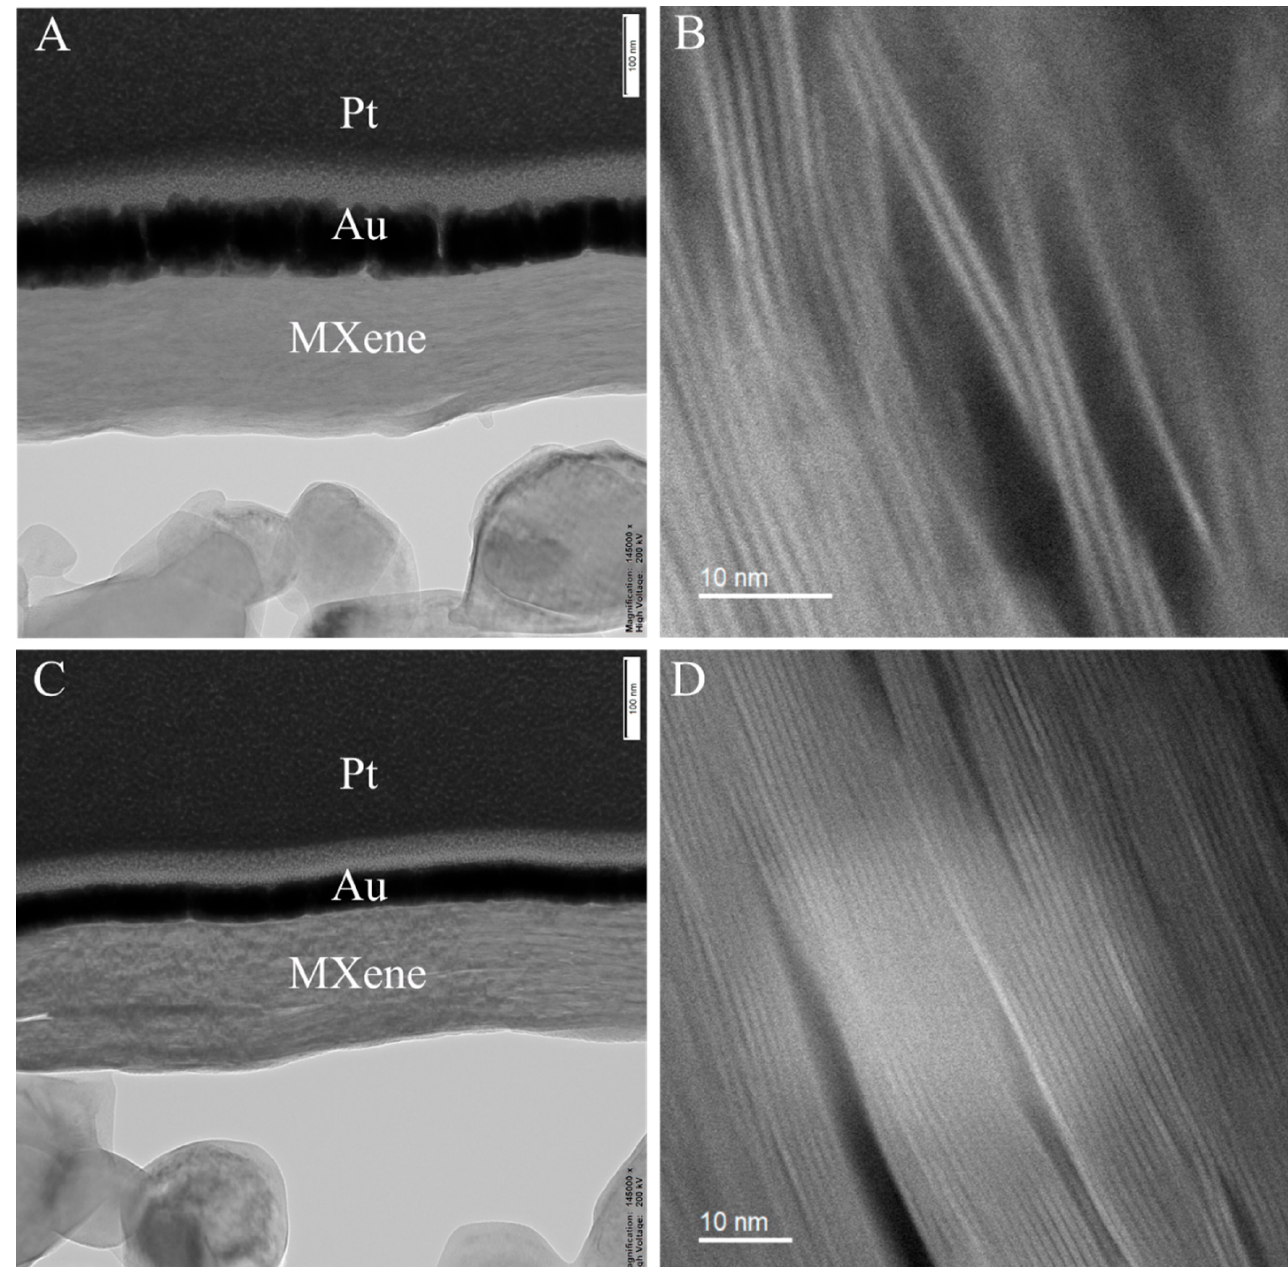
Figure 9. Morphology and structure of exfoliated MXene (Ti 3 C 2 T x ) nanosheets and stacked MXene membranes. ( A ) SEM image showing the cross-section of the sample C 1 _80; ( B ) TEM images of the sample C 1 _80 showing regions containing non-ordered and spaced nanosheets; ( C ) SEM image showing the cross-section of the sample C 1 _500; ( D ) TEM images of the sample C 1 _500 indicating regions with stacked MXene nanosheets.